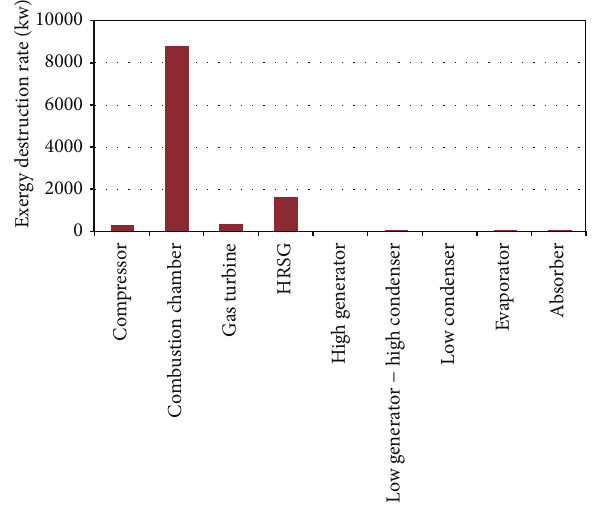
Figure 3: Exergy destruction rate for each component of the system.